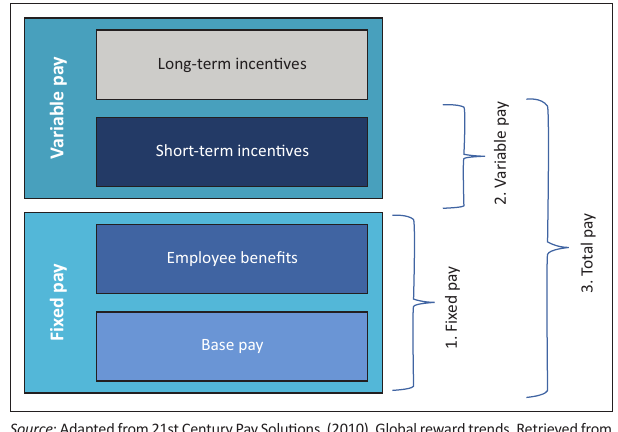
FIGURE 1: Graphical representation of the components of executive